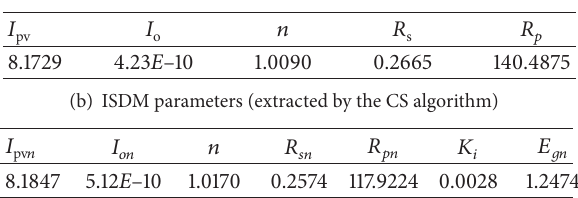
Table 4: Parameters of the KC200GT PV module obtained by the CS